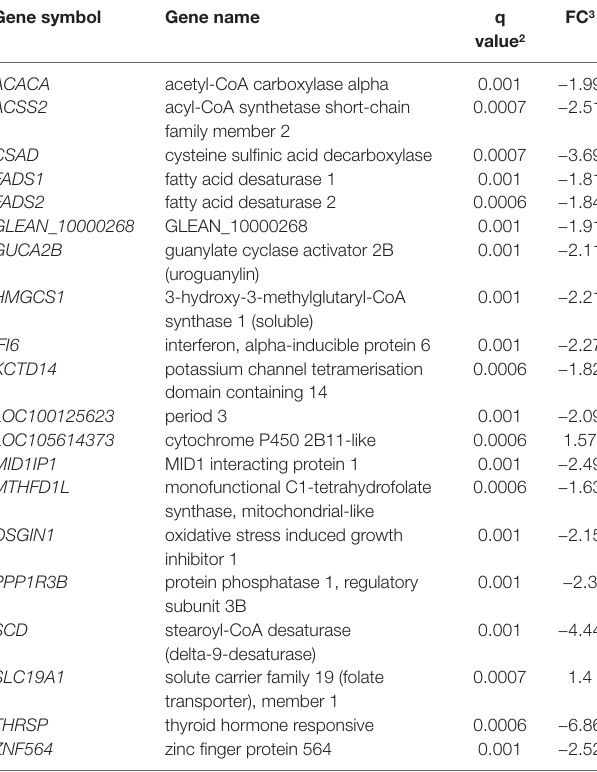
TABLE 3 | Differentially expressed genes in Longissimus thoracis muscle and fold-change in ALF–CON 1 contrast.